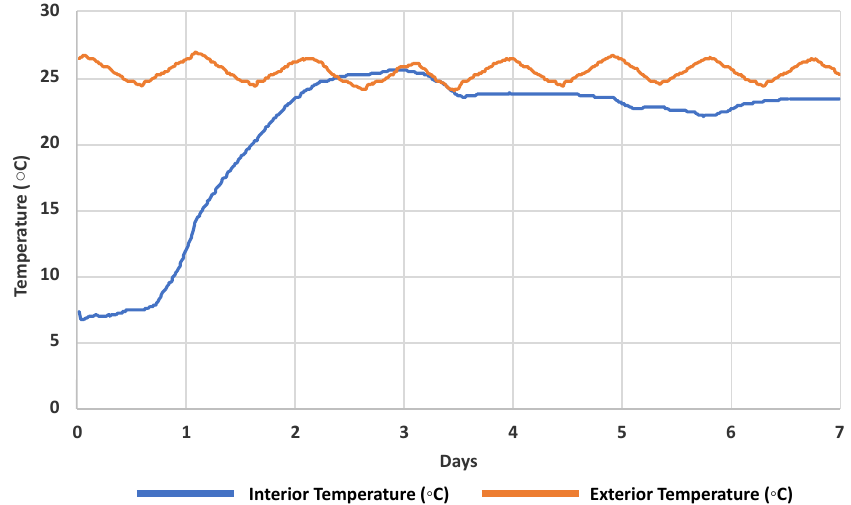
Figure 1. Mean ( n = 3) interior and exterior temperatures of a sample shipping package containing two ice packs (as standardised for all sampling kits) over 7 days.